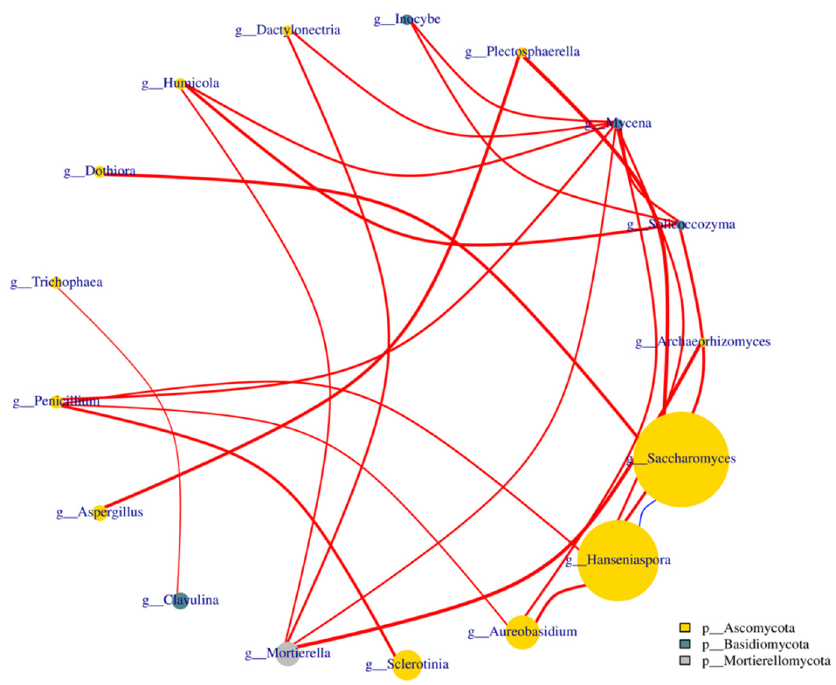
Figure 7. Analytical diagram of genus horizontal species association. The letters on the dots represent the names of different genera, the size of the dots represents the size of abundance, the color of the dots represents the phylum to which they belong, and the right column is the information of the phylum to which they belong; the thickness of the line represents the size of correlation, a red line indicates a positive correlation, and a blue line indicates a negative